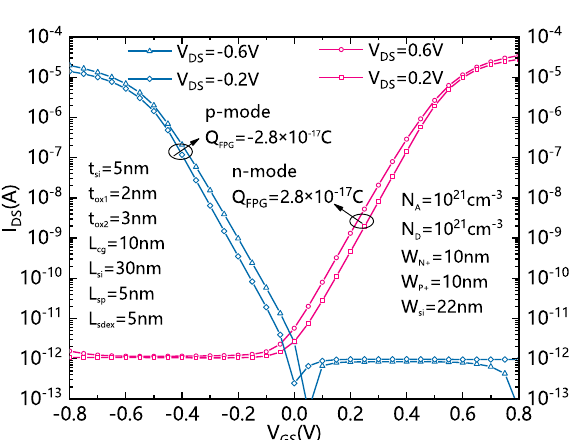
Figure 7. Transfer characteristic of DDN R-FET in both n-mode and p-mode with positively charged and negatively charged